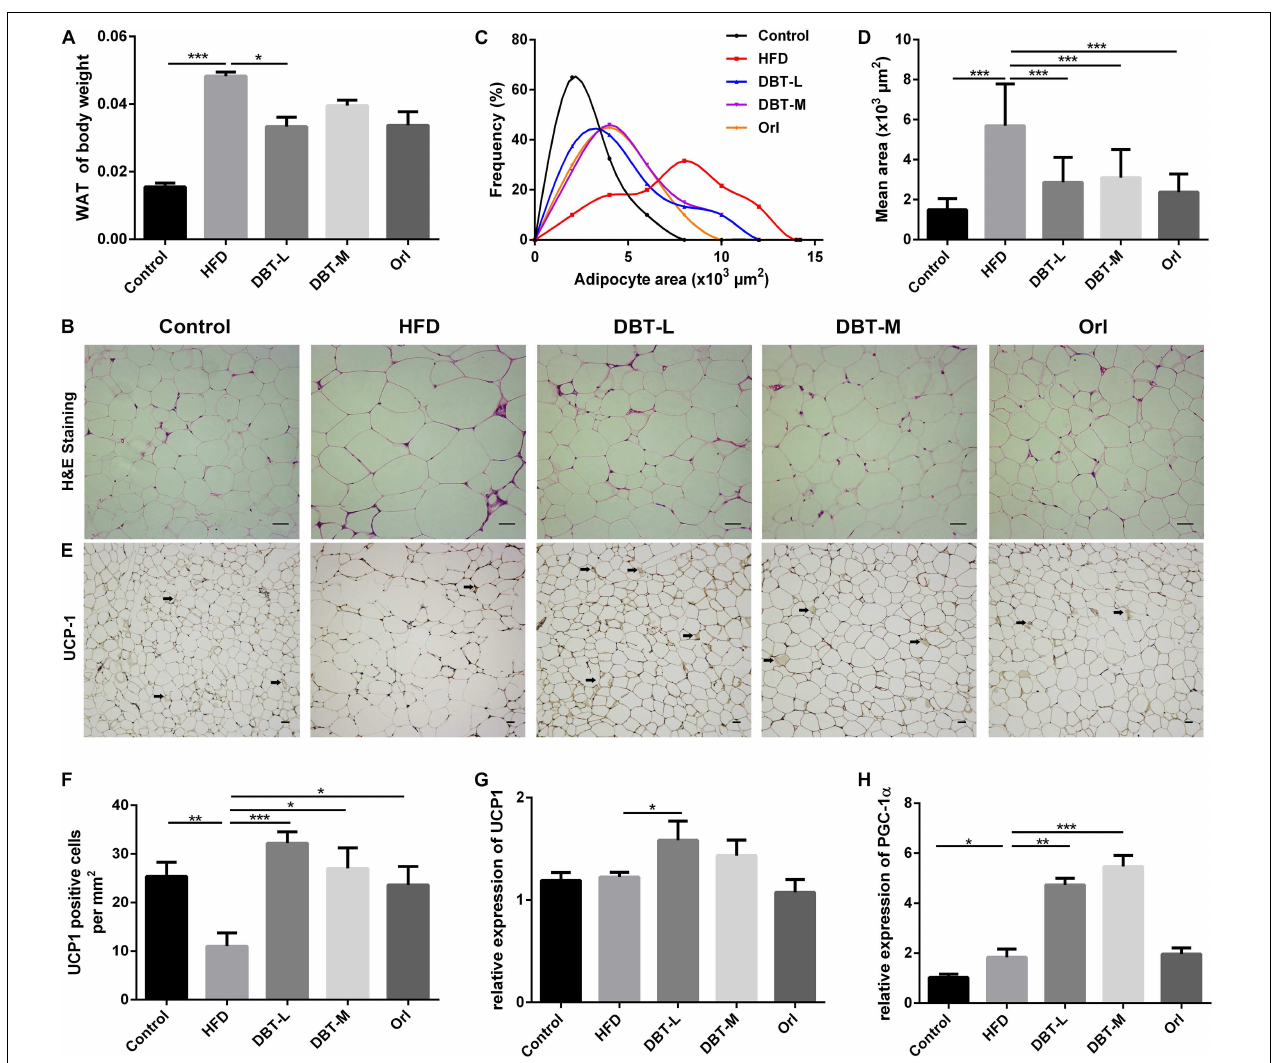
FIGURE 4 | DBT induces epididymal WAT browning. (A) Ratio of epididymal WAT to body weight; (B) Haematoxylin and eosin staining of epididymal WAT, scale bar: 20 µ m; (C) Distribution of area and (D) mean area of adipocytes of epididymal WAT; (E) UCP1 immunohistochemical of epididymal WAT; (F) Numbers of UCP1 positive adipocytes in the images; qPCR analysis of the mRNA levels of UCP1 (G) and PGC-1 α (H) . Results are presented as mean ± SEM ( n = 7). ∗ p < 0.05, ∗∗ p < 0.01, ∗∗∗ p < 0.001 compare with HFD